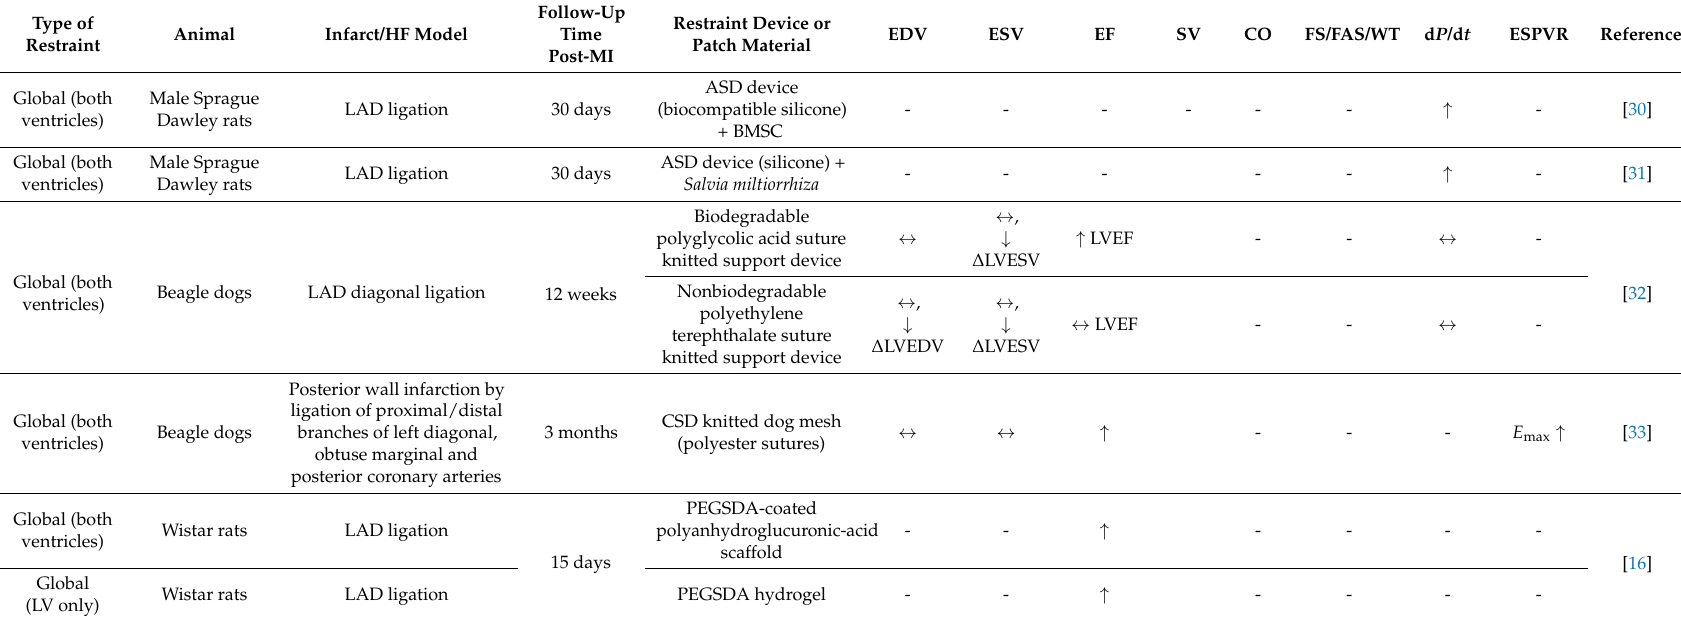
Table 1. Summary of chronic epicardial global restraint studies (those reviewed in [5] are not